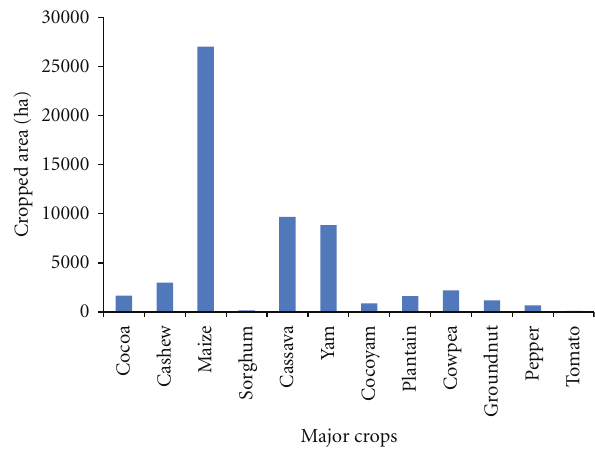
Figure 1: Area cropped (ha) to major crops in Wenchi (Source: MoFA,